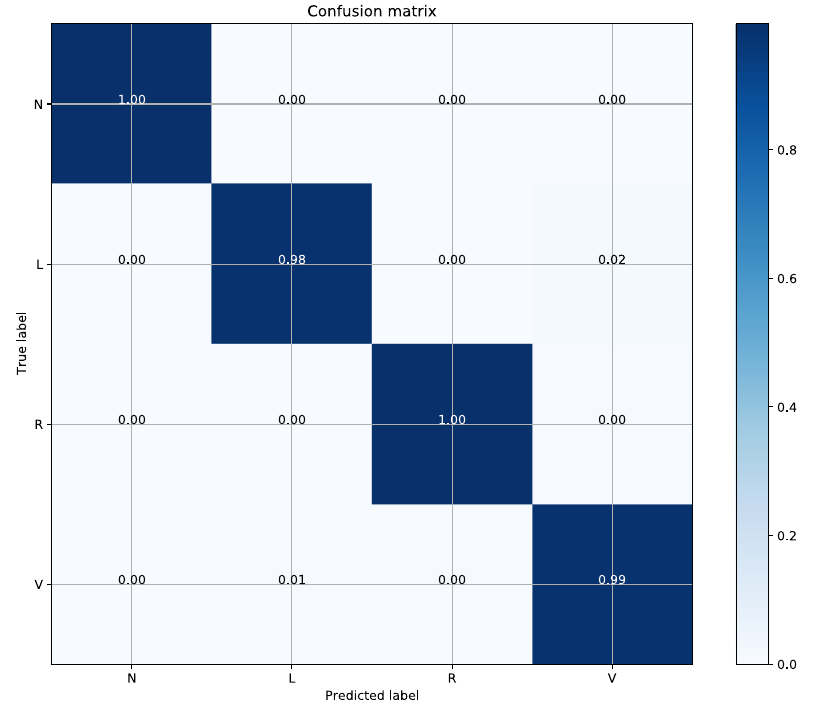
Figure 4: Confusion matrix for the testing